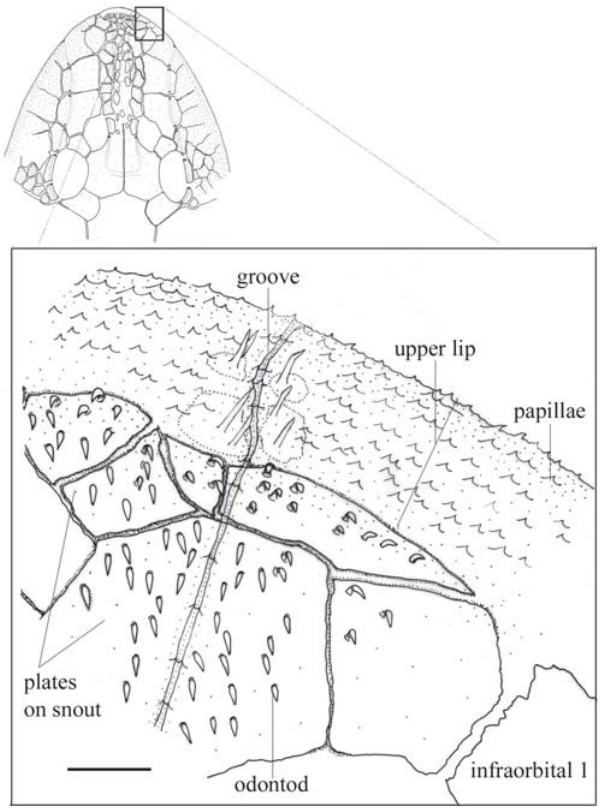
Fig. 52. Detail in dorsal view of anterior portion of head of Harttia loricariformis (MZUSP 66187, 67.7 mm SL). Scale bar = 0.5